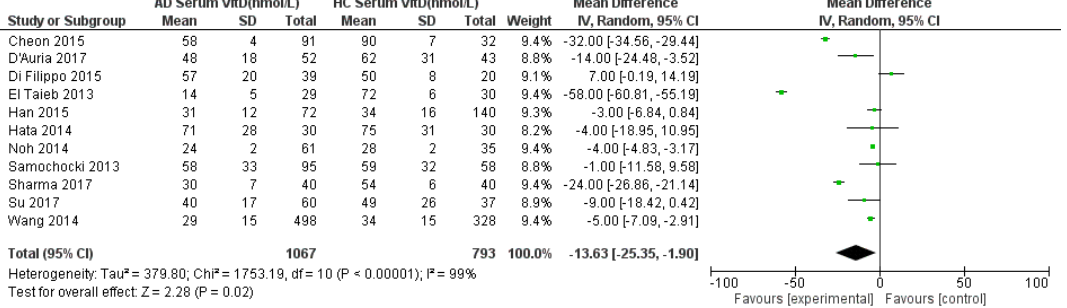
Figure 3. Forest Plot of comparison of serum 25(OH)D levels (nmol/L) in adult and paediatric atopic dermatitis populations versus their age-matched healthy controls, with sub-analysis by age group.